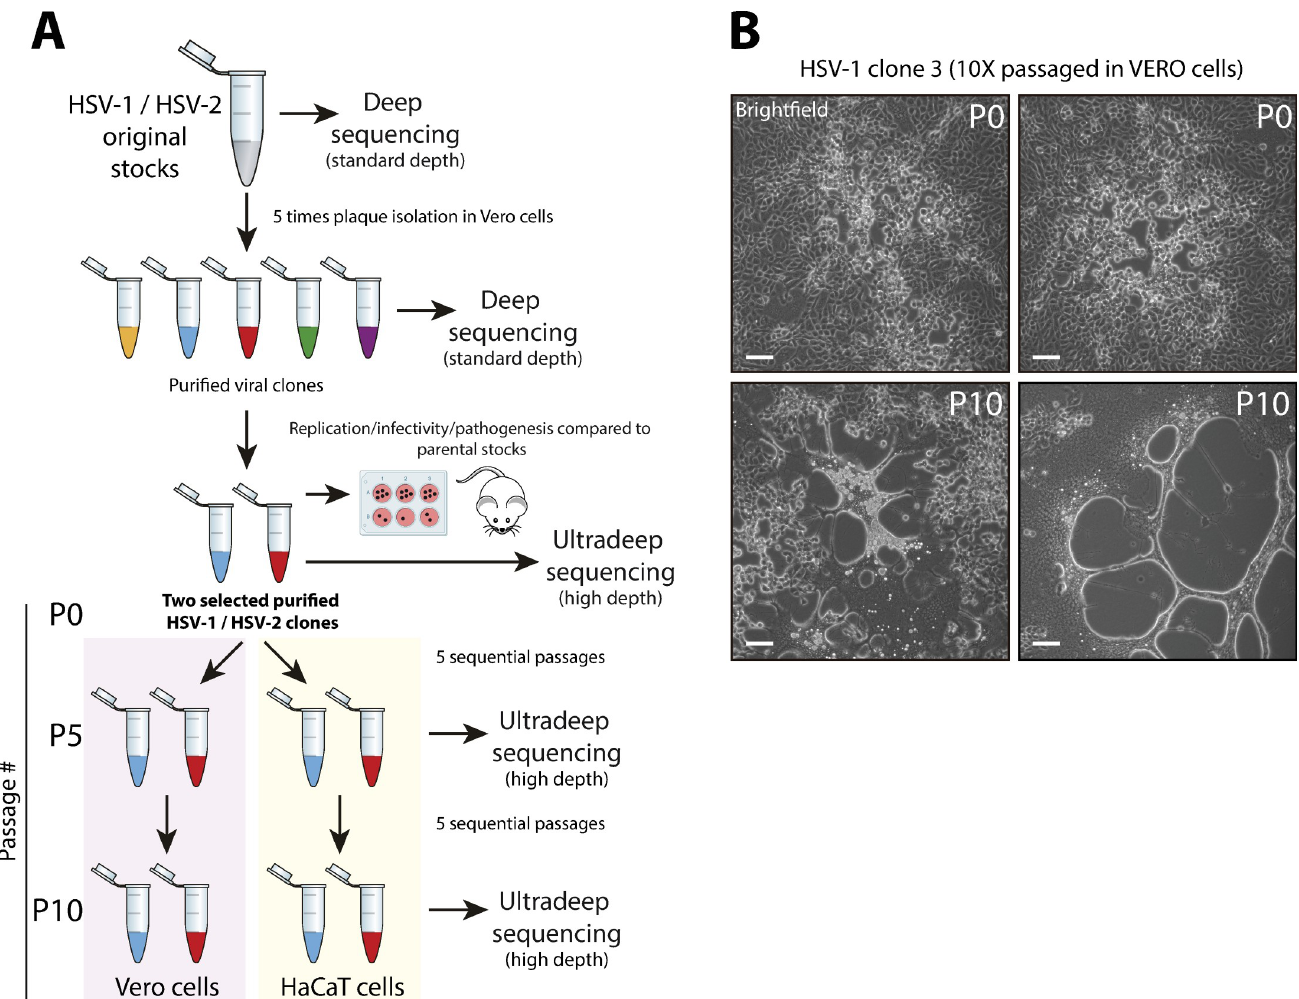
Fig 1. Experimental design of the in vitro generation of genetic variability studies for HSV-1 and HSV-2 subtypes and detected changes in plaque phenotype. (A) Five viral clones from each original stock were five times plaque-purified in Vero cells and then deep sequenced. Two clones were re-sequenced at ultrahigh depth, whose replication, infectivity, and pathogenesis were compared to their corresponding parental stocks in cell culture and animal models of infection (S4 Fig). Those two clones were used to infect Vero and HaCaT cells at an MOI of 0.1 PFU/cell. After 48 hpi, viral progenies were harvested, referring to this infection cycle as a passage. Viral populations from each plaque-purified clone were ultra-deep sequenced after five and ten passages in each cell line. (B) Four representative pictures are showing the plaque morphology phenotype of HSV-1 clone 3 in Vero cells (48 hpi), before (passage 0, P0), and after ten passages (P10) in Vero cells. This syncytial plaque phenotype is due to the previously well-described syncytia-inducing mutation in UL27 CDS (see Sheet I in S1 Table, variant #38: R858H) [44]. Tiled images (4 x 4) were taken using a Leica DM IL LED inverted microscope equipped with a Leica DFC3000-G digital camera. Scale bars indicate 100 μ m.